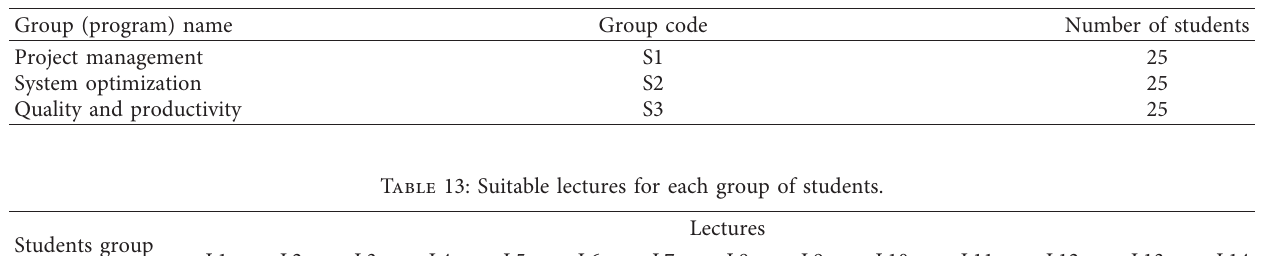
Table 12: The number of students in each group.